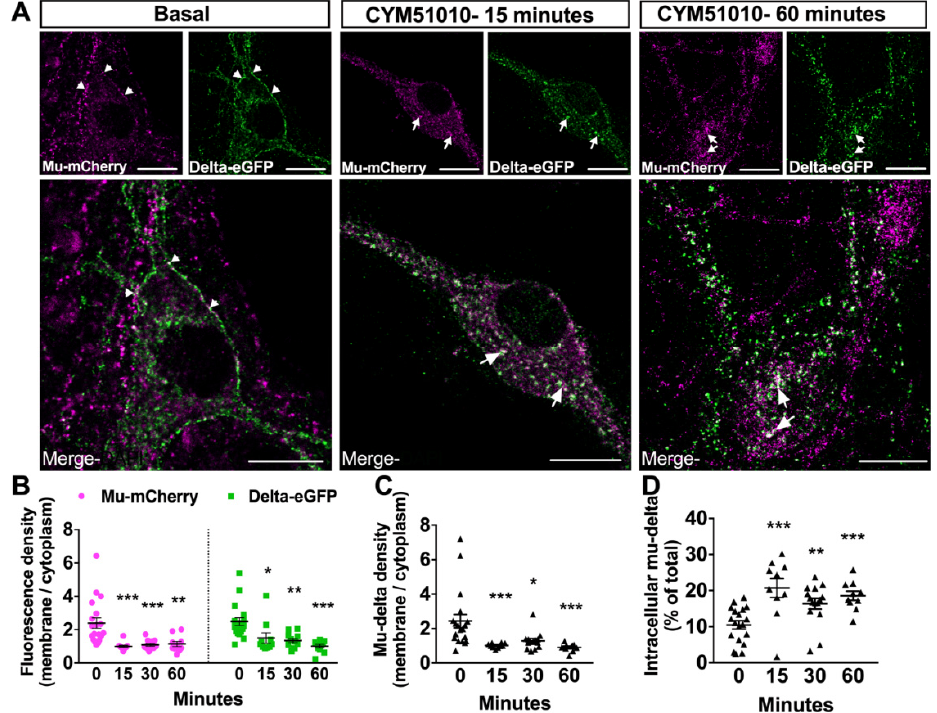
Figure 1. Mu and delta opioid receptors co-internalize upon CYM51010 activation in primary hippocampal cultures. ( A ) Representative confocal images showing mu-mCherry and delta-eGFP fluorescence localized at the plasma membrane (arrowheads) under basal condition or internalized in vesicle-like structures 15 or 60 min after CYM51010 (400 nM) application (arrows). Scale bar = 10 µ m. ( B ) Receptor internalization induced by CYM51010 application (400 nM) expressed as a ratio of membrane-associated versus intracellular fluorescence densities for each receptor. Two-way ANOVA F treatment (3, 94) = 17.98; p < 0.0001. F receptor (1, 94) = 1.06; F interaction (3, 94) = 0.54. Tukey’s post hoc test for mu-mCherry, *** p < 0.001, ** p = 0.01. Tukey’s post hoc test for delta-eGFP, * p = 0.02, ** p = 0.002, *** p < 0.001; n = 10 to 20 neurons per group from at least three independent cultures. ( C ) Subcellular redistribution of mu–delta heteromers expressed as a ratio of membrane-associated versus intracellular fluorescence densities for co-localized mu-mCherry and delta-eGFP receptors. One-way ANOVA (F (3, 48) = 13.64; p < 0.0001) followed by multiple-comparison Dunn’s post hoc test. * p = 0.03, *** p < 0.001; n = 10–20 neurons per group from at least three independent cultures. ( D ) Fraction of cytoplasmic mu-delta heteromers expressed as the percentage of mu-mCherry and delta-eGFP overlapping objects detected in vesicle-like structures at the different times. Kruskal Wallis test ( p < 0.0001) followed with multiple comparisons Dunn’s test. ** p < 0.01, 30 min vs basal, *** p < 0.001 15 min and 60 min vs basal. N = 10 to 20 neurons per group from at least 3 independent cultures.